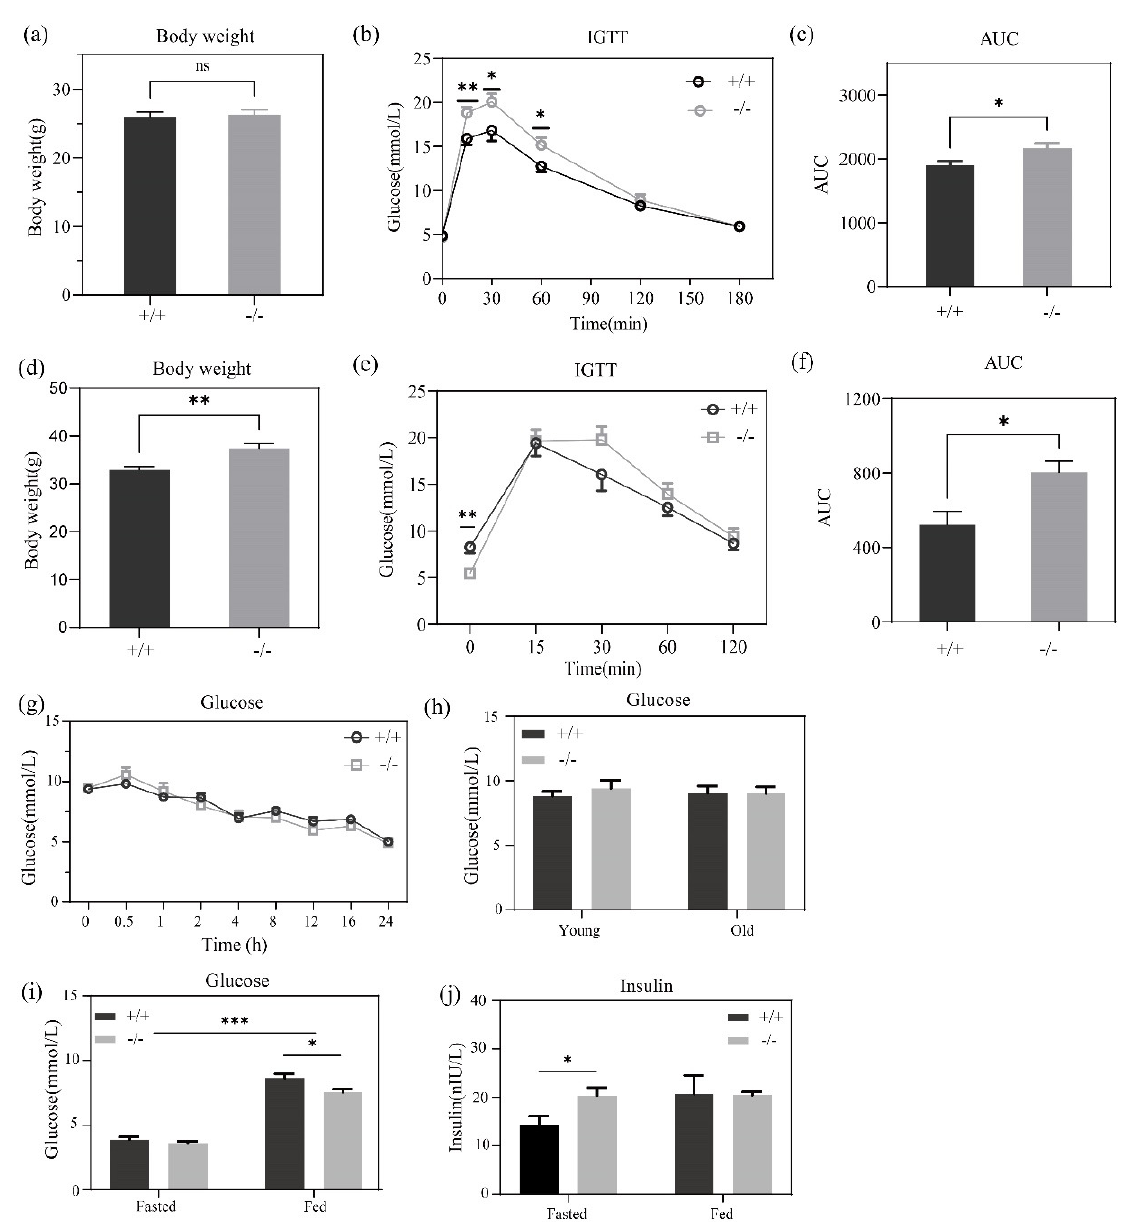
Figure 2. Body weight, IGTT and AUC analysis of mice aged 8 weeks ( a – c ) and 54 weeks ( d – f ); ( g ) mice serum glucose after 0–24 h fasting; ( h ) serum glucose in young (8 weeks) and old (55 weeks) mice on fed status; ( i , j ) serum glucose and insulin of mice fasted for 16 h and after intragastric administration of 2 g/kg lactalbumin powder (aged 8 weeks) . The data are shown as the means ± SE. The AUC was calculated independently for every single mouse. ns, nonsignificant. The data were analyzed using an unpaired Student’s t -test, p > 0.05. * p < 0.05, ** p < 0.01, *** p < 0.001, n = 7–10.